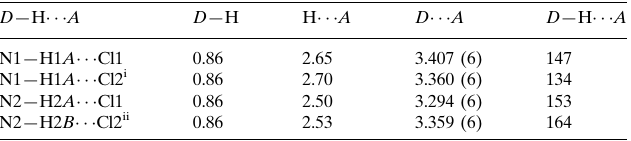
Hydrogen-bond geometry (A˚ , (cid:2)